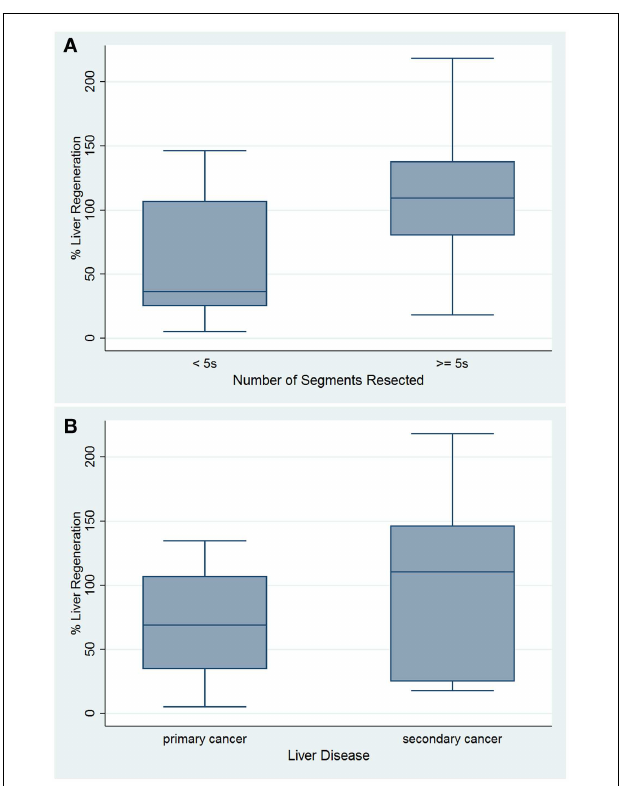
FIGURE 1 | Box plots of percentage of liver regeneration by number of segments resected (A) and based on type of liver malignancy (B).